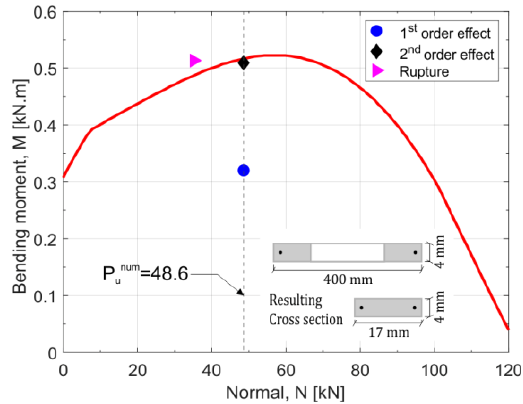
Figure 11. Cross section strength in the column